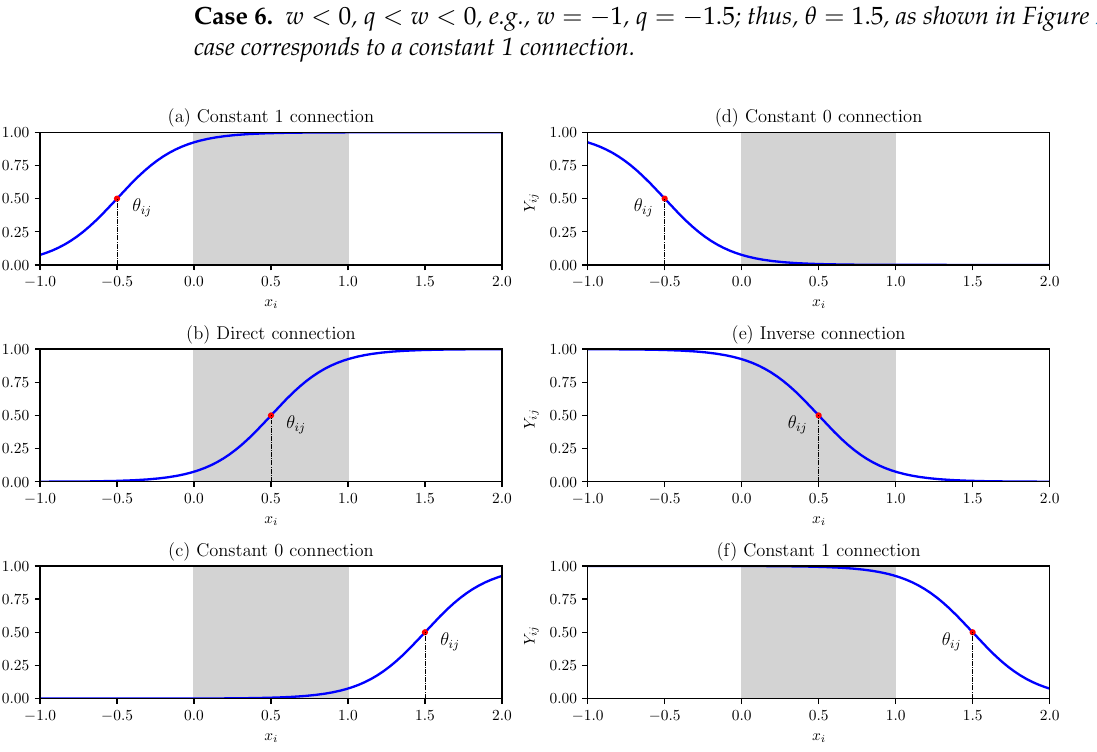
Figure 2. Four types of synaptic connection states. The connection state of a synapse is determined by the synaptic parameters w ij and q ij uniquely. Note that the ranges of x i and Y ij are [0,1]. The values of w and q are all initialized in the range [ 1.5, 1.5 ] . Consequently, − a synapse is randomly connected to a dendritic branch. After training, the synaptic connection will land on one state of the four connection states, as shown in Figure